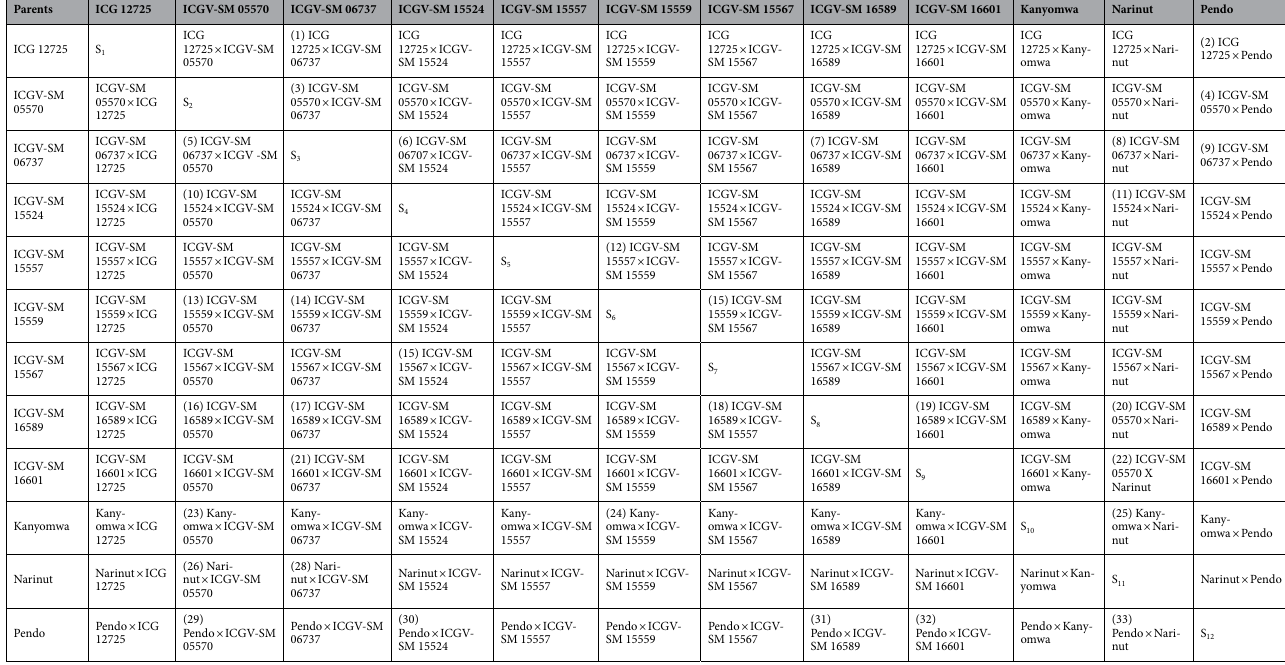
Table 3. A 12 × 12 diallel mating scheme in groundnut showing the overall and successful crosses. Numbers (1) to (33) denote successful crosses, which were used for genetic analyses. S 1 to S 12 denote selfs.